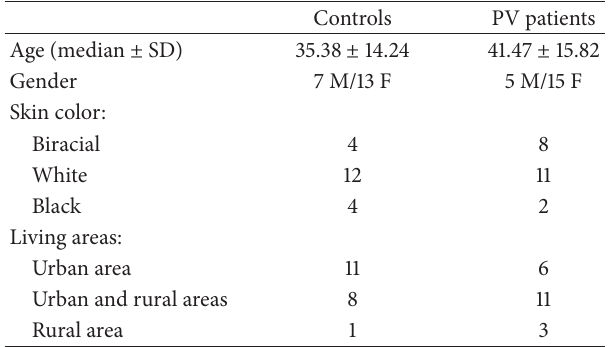
Table1:ClinicalfindingsincontrolsandinpatientswithPemphigus vulgaris